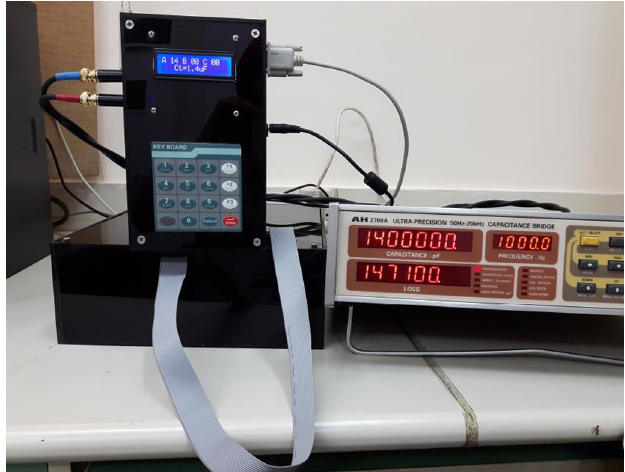
Fig. 7. Automated capacitance measurements using ultra-precision capacitance bridge.